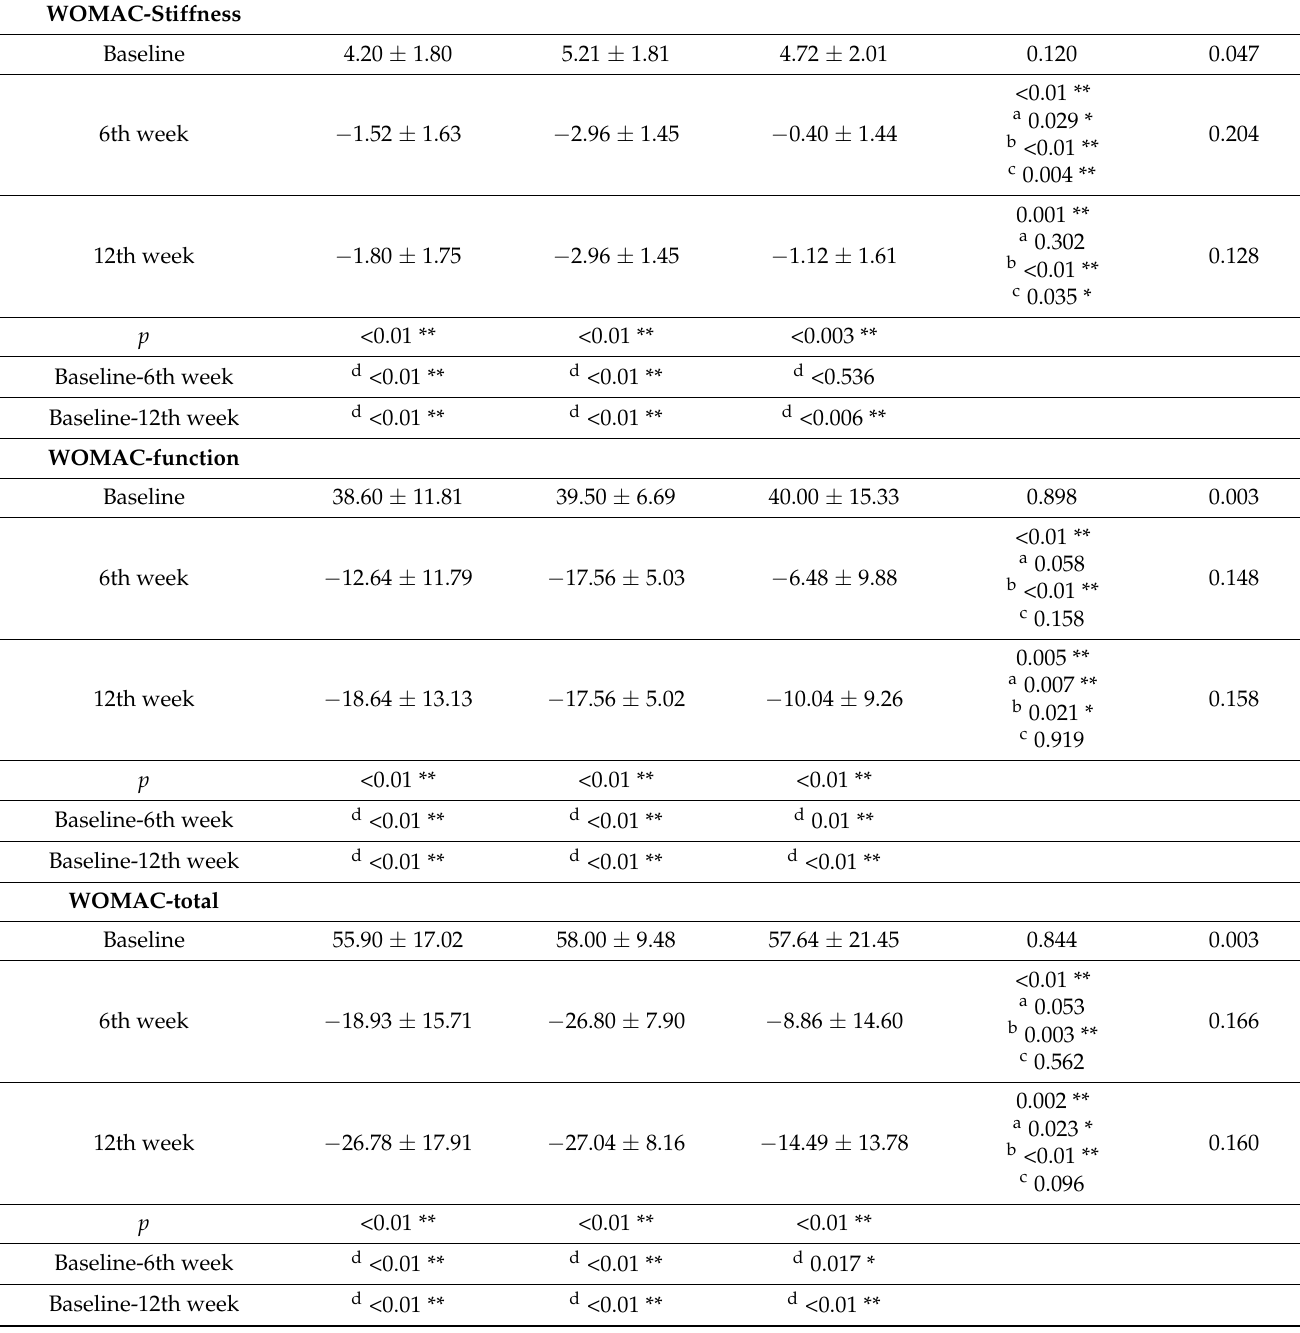
Table 3. WOMAC scores of groups and